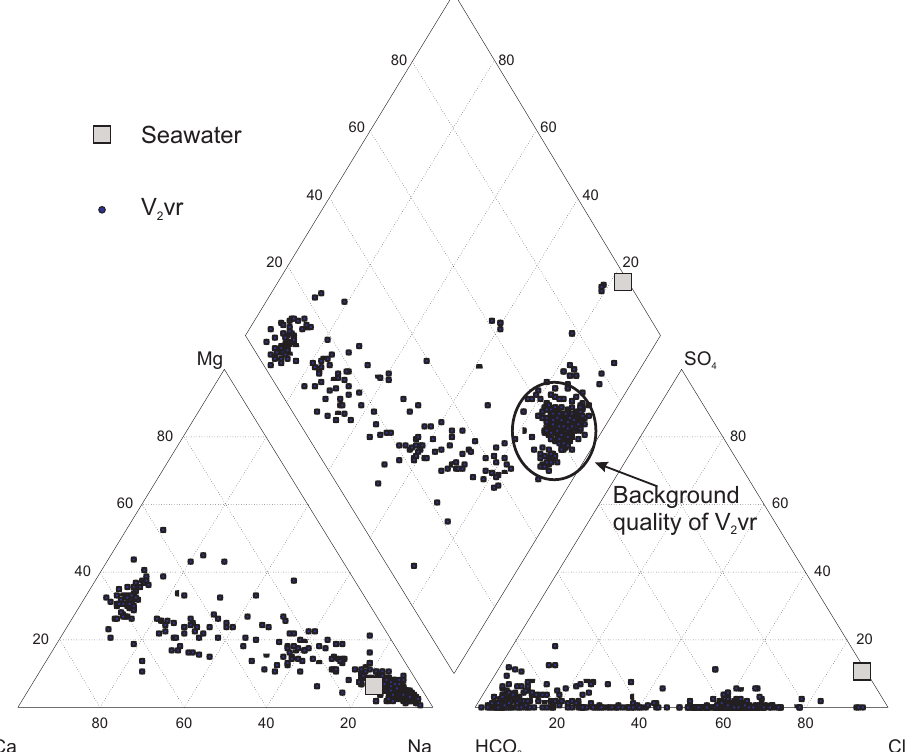
Fig. 5. Piper plot of V 2 vr showing the range of all samples and the position of samples with natural background quality in V 2